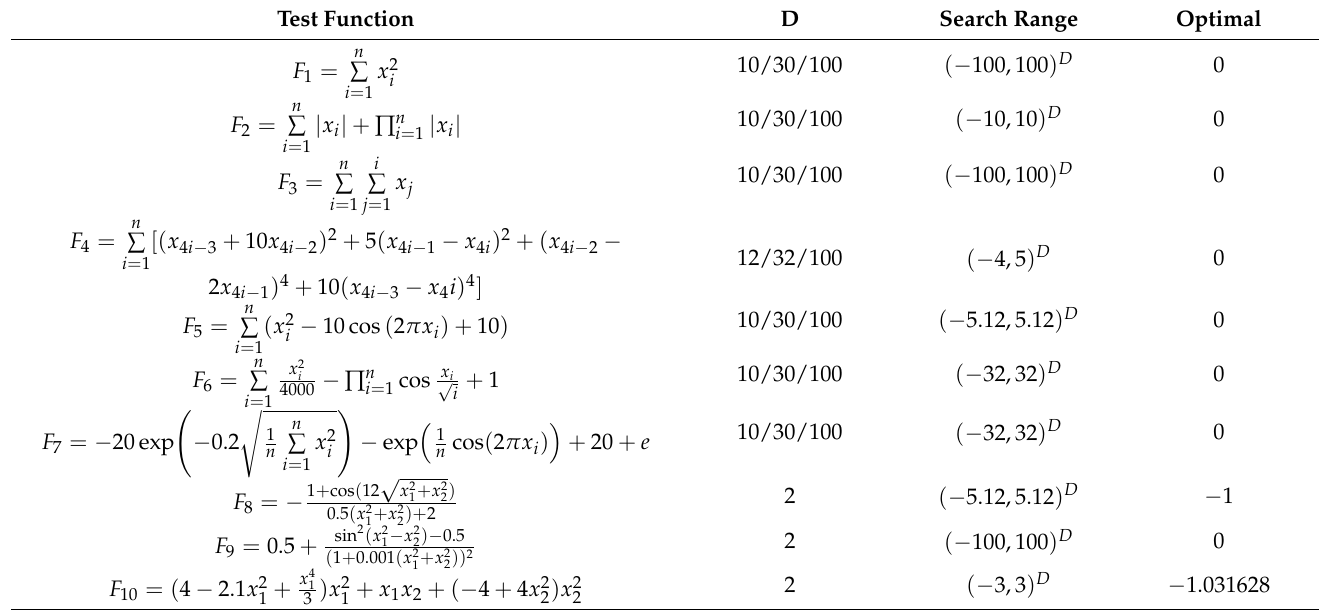
Table 1. Details of the mathematical optimization